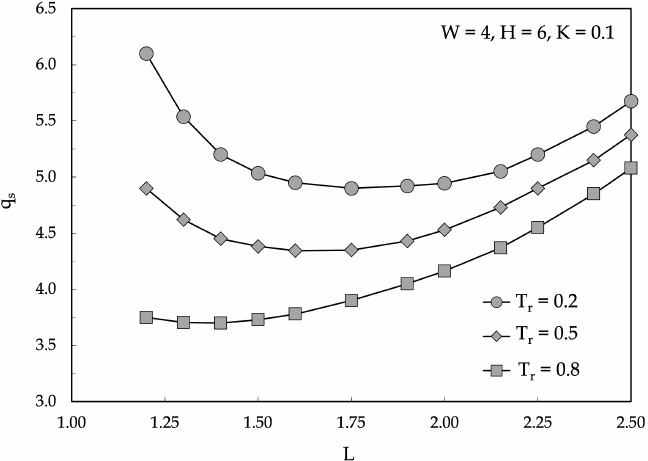
Figure 9. Distributions of the dimensionless heat loss from the supply pipe q s versus L using T r as a